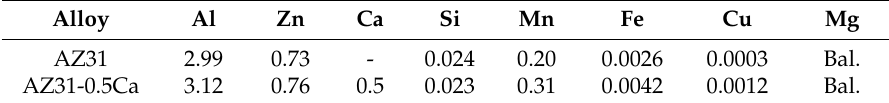
Table 1. The composition of AZ31 and AZ31-0.5Ca alloys.